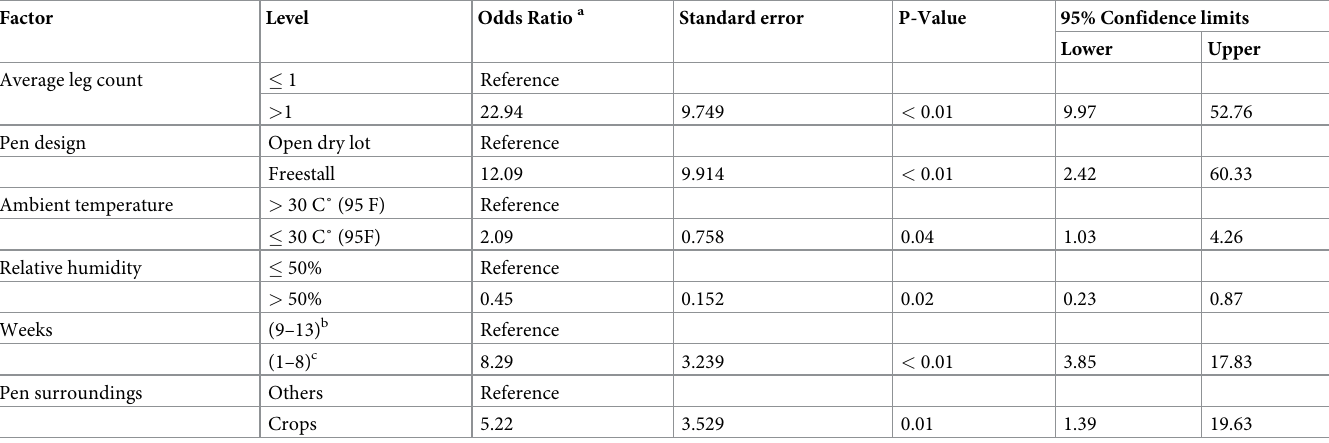
Table 2. Final generalized linear mixed model with logit link predicting cow bunching at the pen level using Stable fly counts on cow legs on 10 California